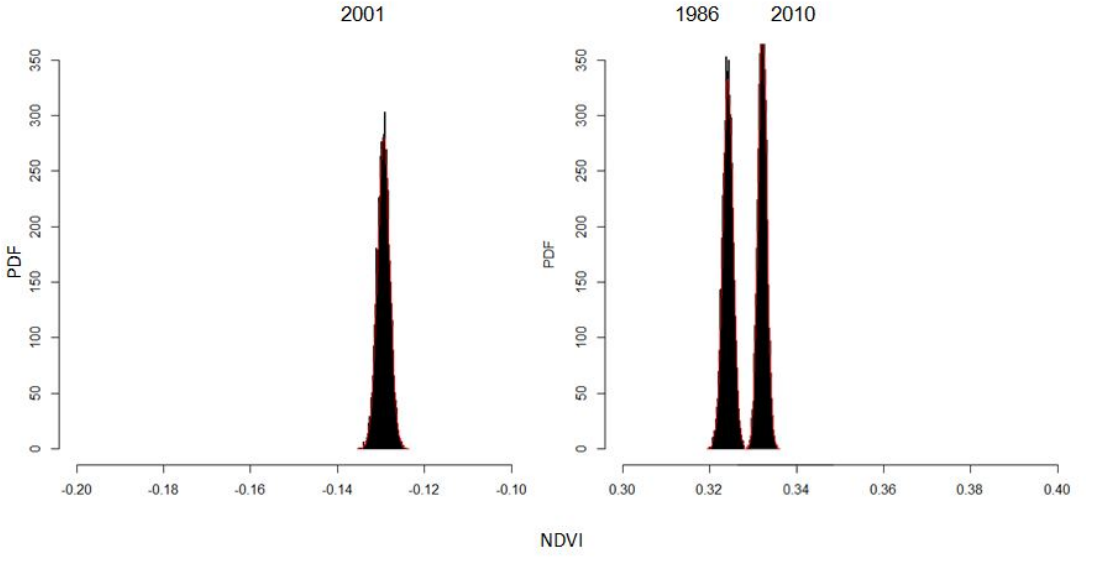
Figure 7. Probability density function calculated from the Monte Carlo Method (MCM) of the Normalized Difference Vegetation Index